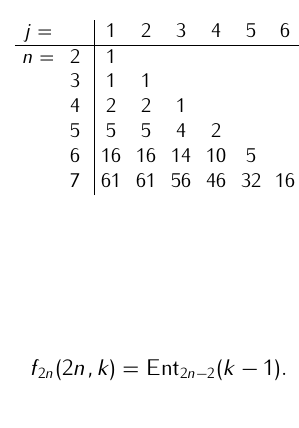
Table 2. The Entringer